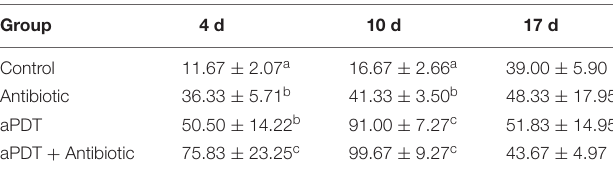
TABLE 4 | Expression of bFGF in tissues of burn wound sites as determined by immunochemistry.